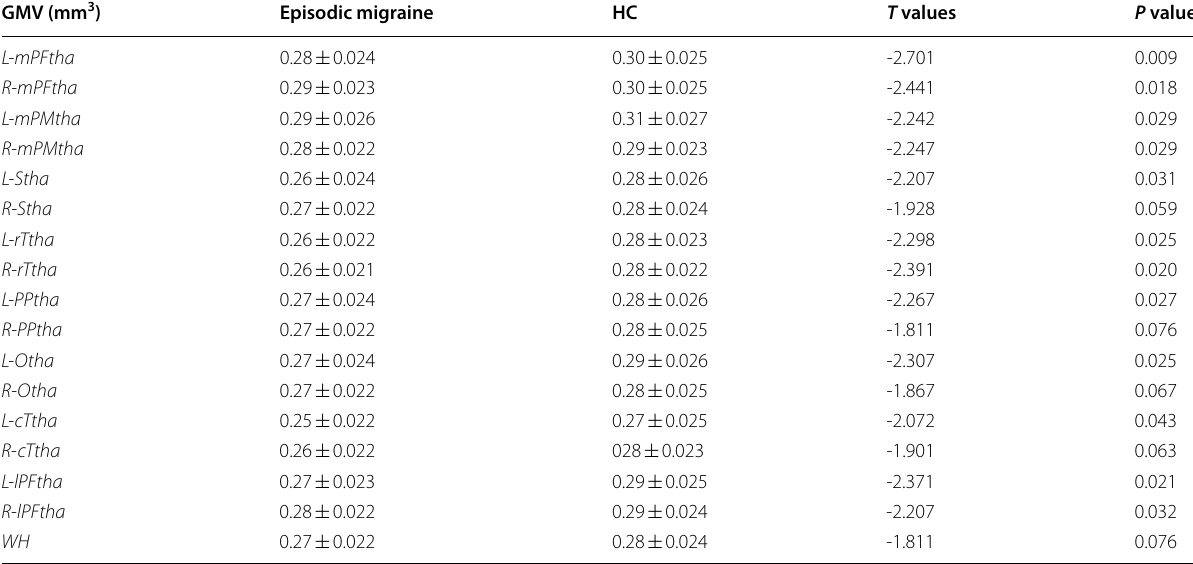
Table 3 GMV changes in the thalamic subregions in patients with episodic migraine compared with HCs